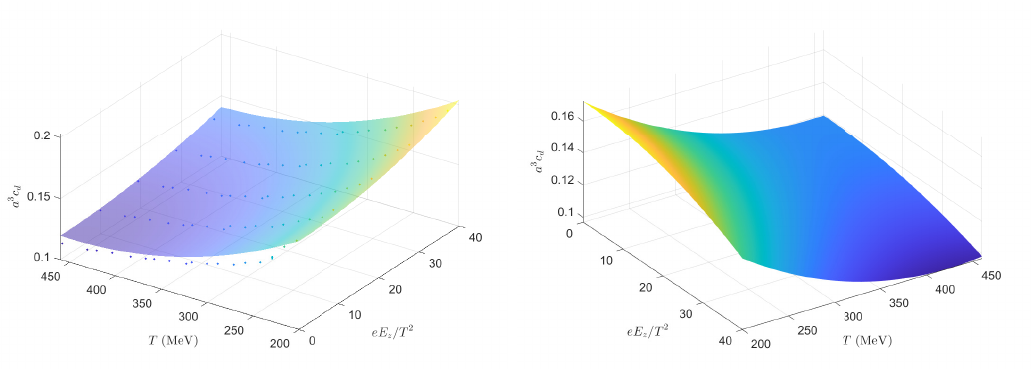
Figure 11 . Same as figure 10 but for c T,E z